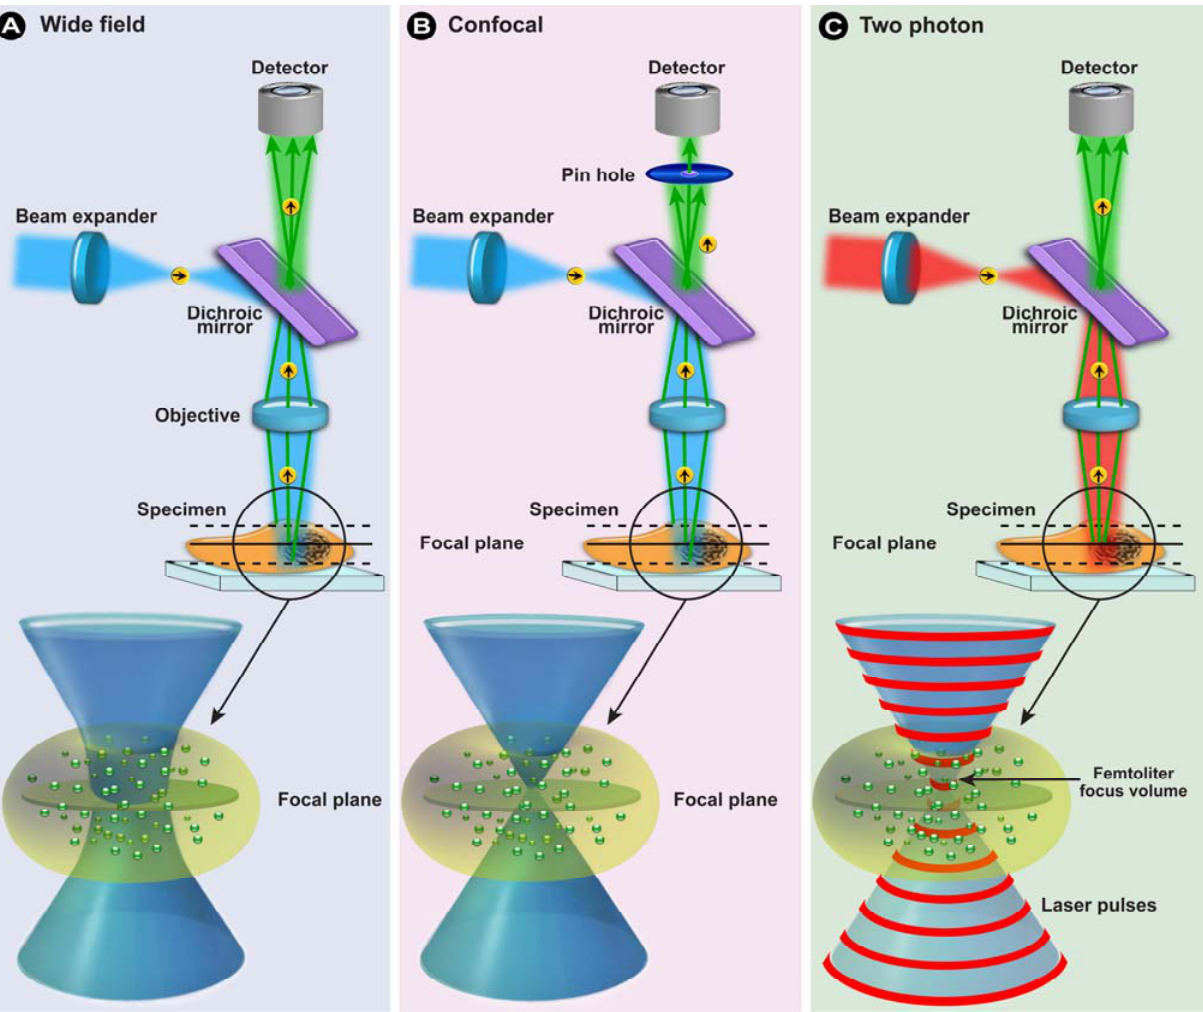
Figure 9. In confocal microscopy ( B ) the concept of illuminating the sample with excitation light ( e.g. , blue light) and the sample emitting light with a longer wavelength ( e.g. , green light) is identical to the general principles of fluorescence in wide field microscopy ( A ). The differences to wide field microscopy are: (i) the excitation laser light is scanned over the sample and the emitted light originates from this area; (ii) on the detection beam path a pinhole aperture in front of the detector prevents light emitted from above or below the focal plane (dotted lines) from reaching the detector; and (iii) because only light from the focal plane (solid line) reaches the detector an optical section is generated. ( C ) In two-photon microscopy, a high flux of excitation photons from a pulsed laser caused the simultaneous absorption of 2 long wavelength photons and emission of a photon with a shorter wavelength (anti-Stokes). Because excitation is restricted to a small femtoliter focal volume, out-of-focus emission is negligible and thus no pinhole is